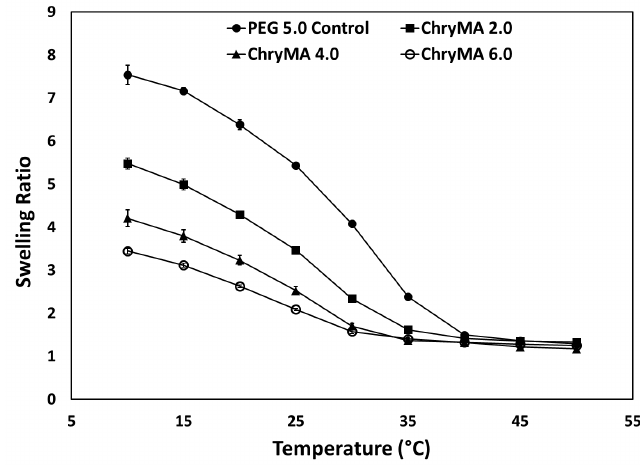
Figure 5. Temperature dependent swelling profile of ChryMA hydrogels.